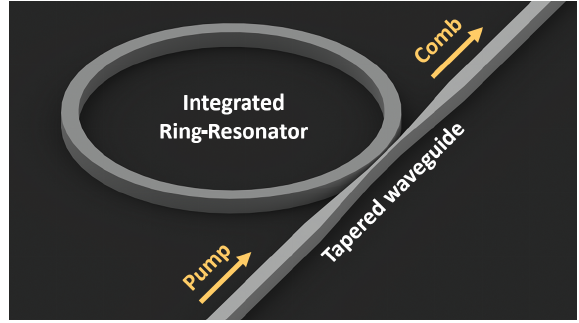
Figure 4: (Color online) The two main coupling configurations for integrated ring-resonators. The Q -factor associated to every loss mechanism is indicated in the figure ( Q in , Q ext,t , and Q ext,d for the intrinsic, through-port, and drop-port losses, respectively). (a) Add- through coupling. Note that this nomenclature is not standard, but it is used here for being intuitive. (b) Add-drop